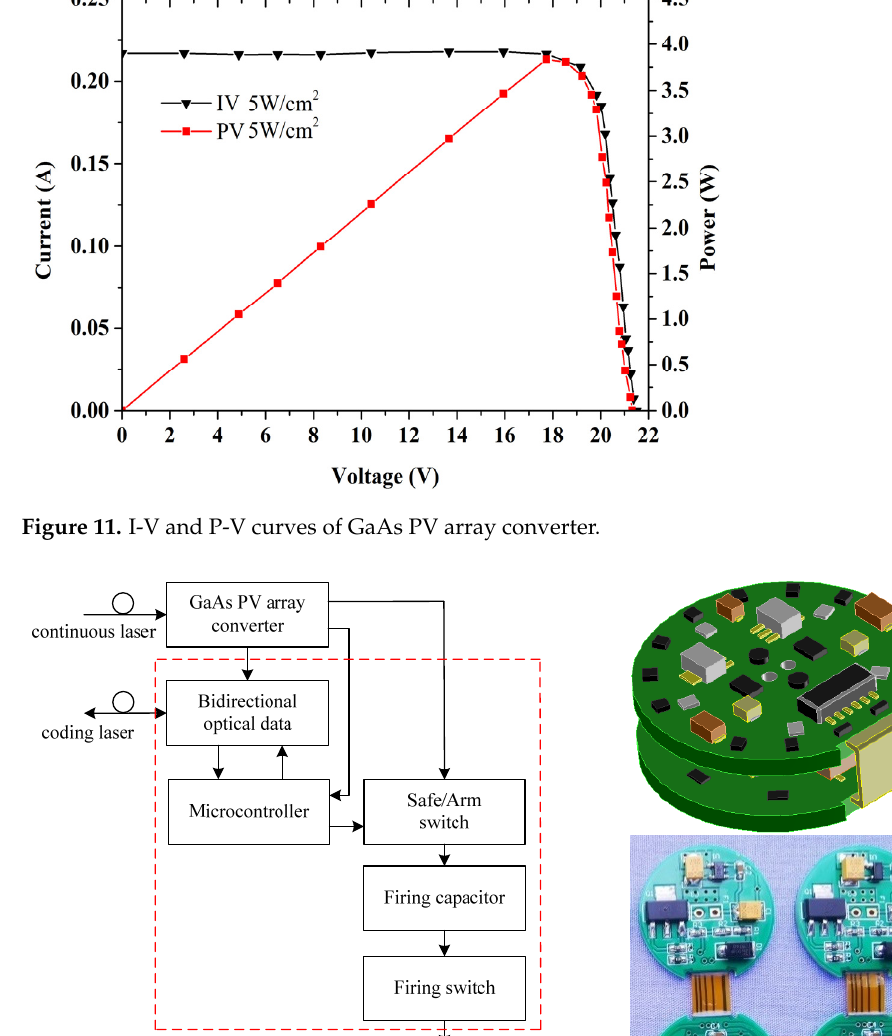
Figure 10. GaAs PV array converter.